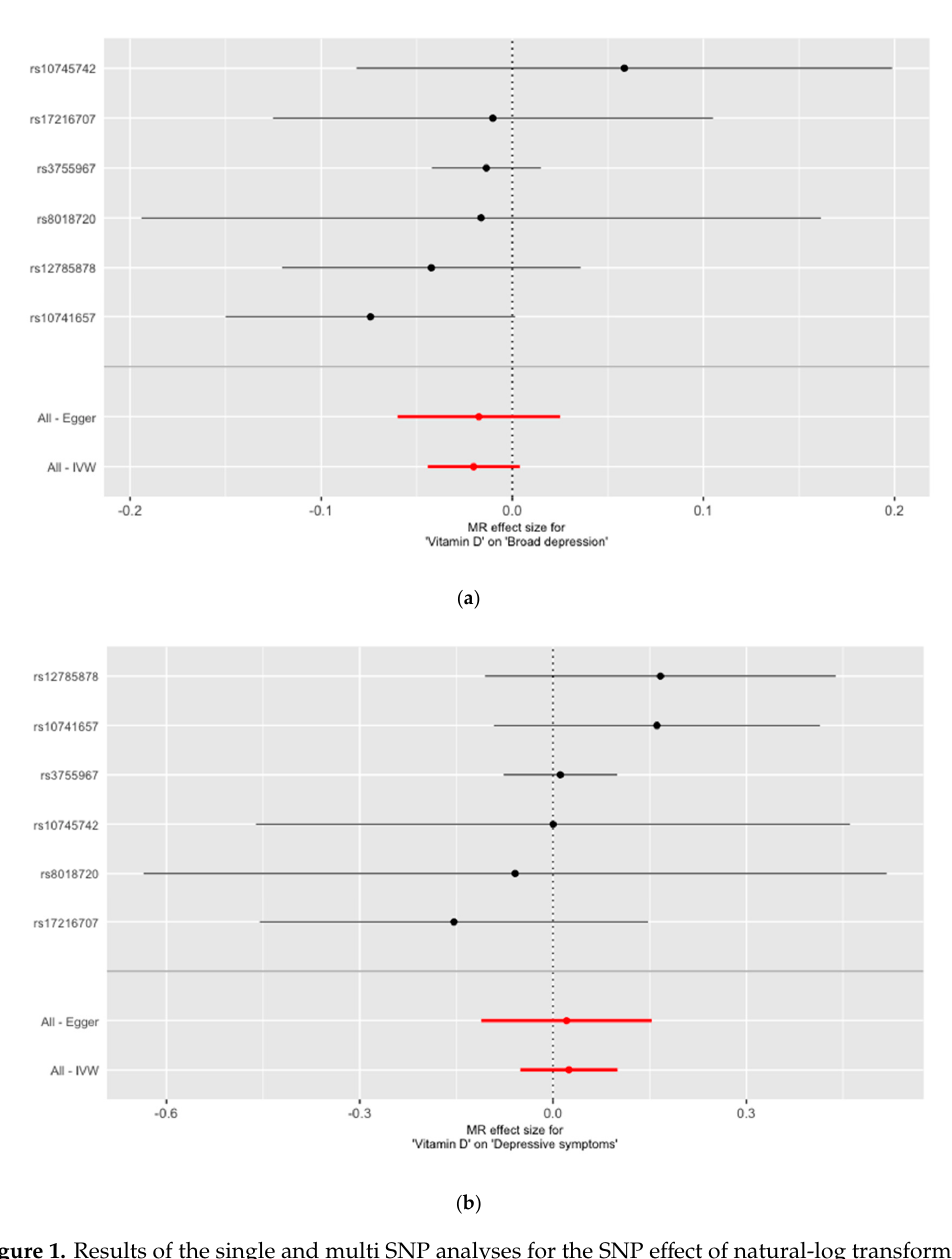
Figure 1. Results of the single and multi SNP analyses for the SNP e ff ect of natural-log transformed 25(OH)vitamin D on ( a ) broad depression, and ( b ) depressive symptoms. The black lines visualize the results of single SNP analyses, the red lines visualize the results of the multi SNP